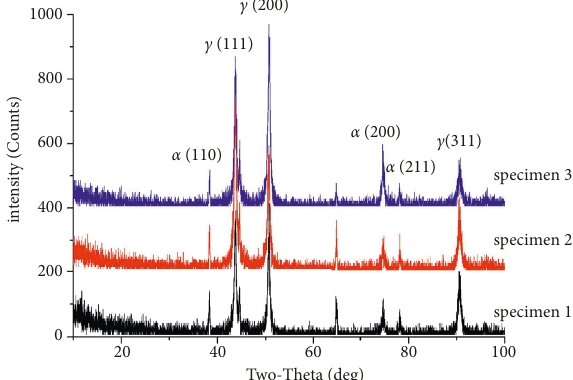
Figure 10: XRD patterns of the three